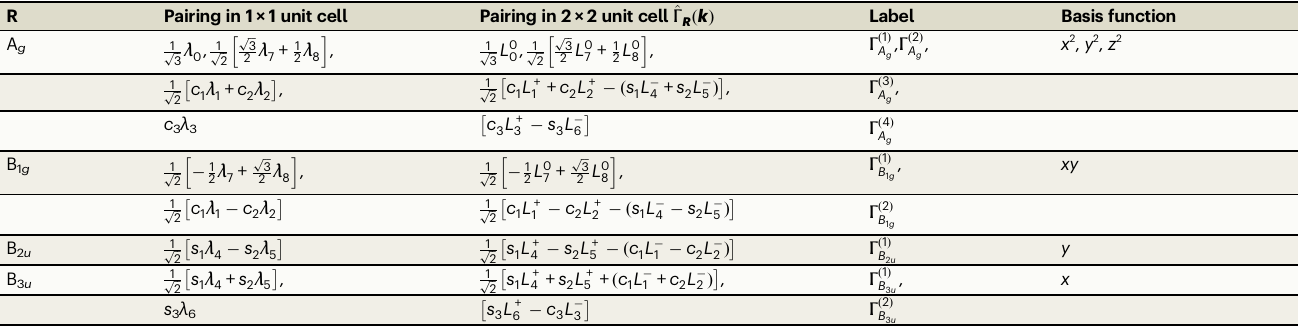
Spin-singletsuperconductingpairings areclassi fi ed byirreducible representations(R) ofthe point group D 2 h . Thecondensation of ^ Γ R channels can lowerthe interaction energy,which preservesthe T 1 × 1 -translational symmetry. Themomentum dependence ofpairing gap functions is abbreviated by Þ (cid:2) ð cos k (cid:4) R k (cid:4) R Þ .Toexpresspairingfunctionsinboth1×1and2×2unitcells,the3×3GellMannmatrices λ a andthe12×12matrices L ± ,0 ð c i , s i i ,sin i M ±